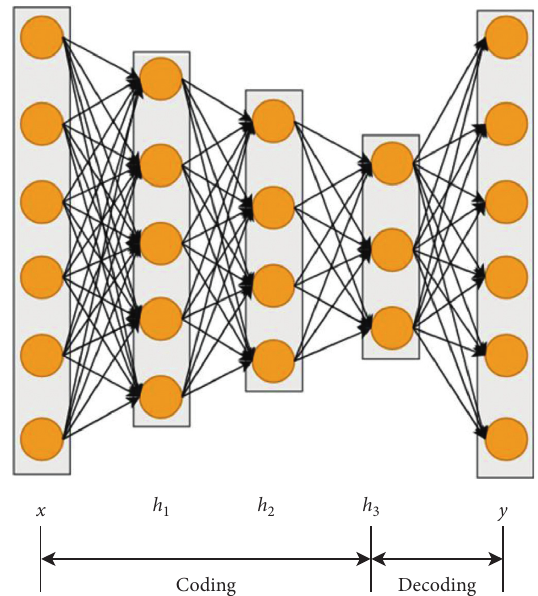
Figure 7: Autoencoding and decoding deep